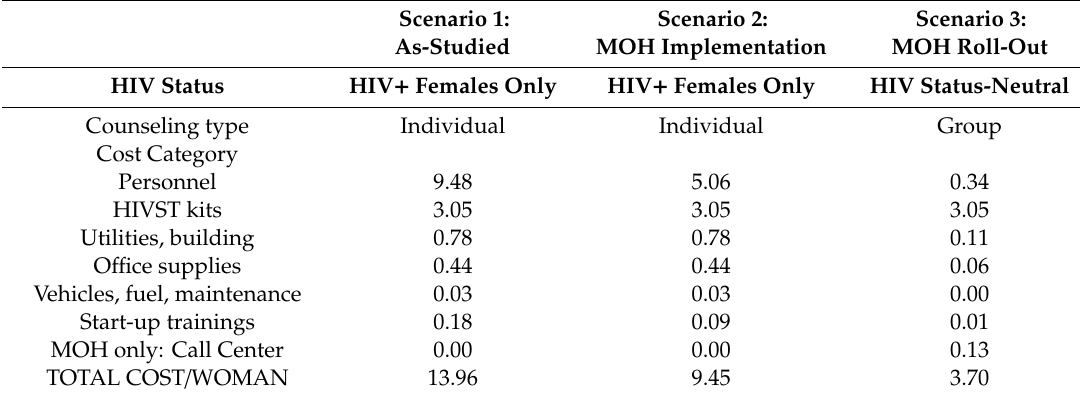
Table 1. Average costs per HIVST kit distributed to a pregnant woman, by scenario (2019 USD).